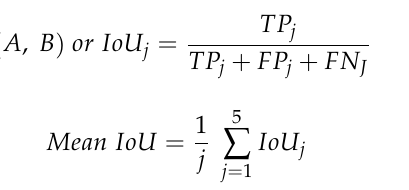
Table 3. Confusion matrix for the predicted and actual label in performance measurement. Predicted Positive Predicted Negative Ground Truth Positive True Positive (TP) True Negative (TN) Ground Truth Negative False Positive (FP) False Negative